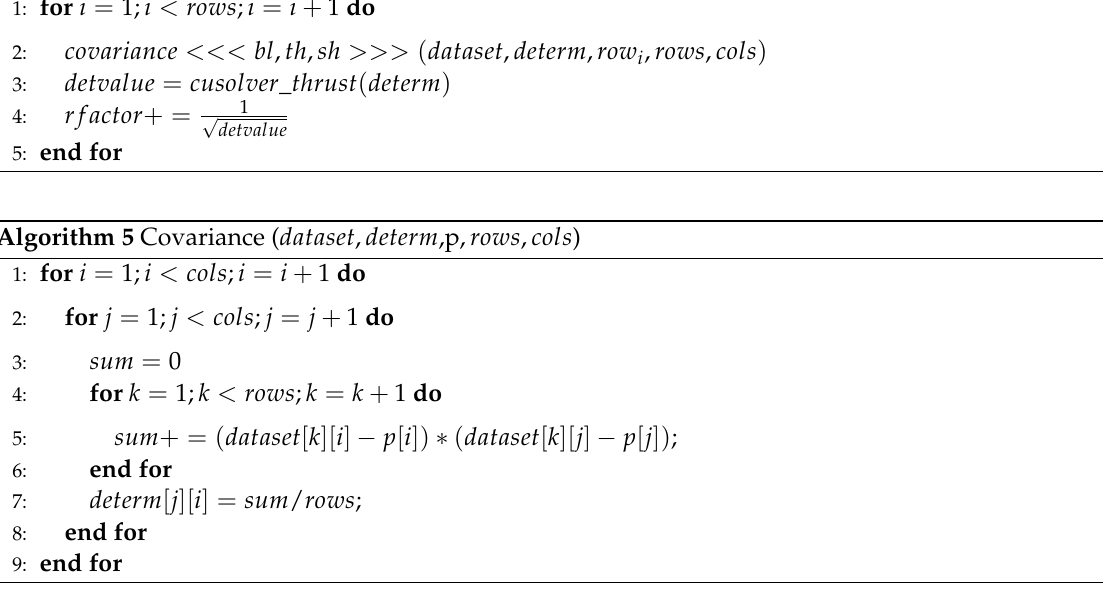
Algorithm 4 R Factor calculation algorithm in GPU